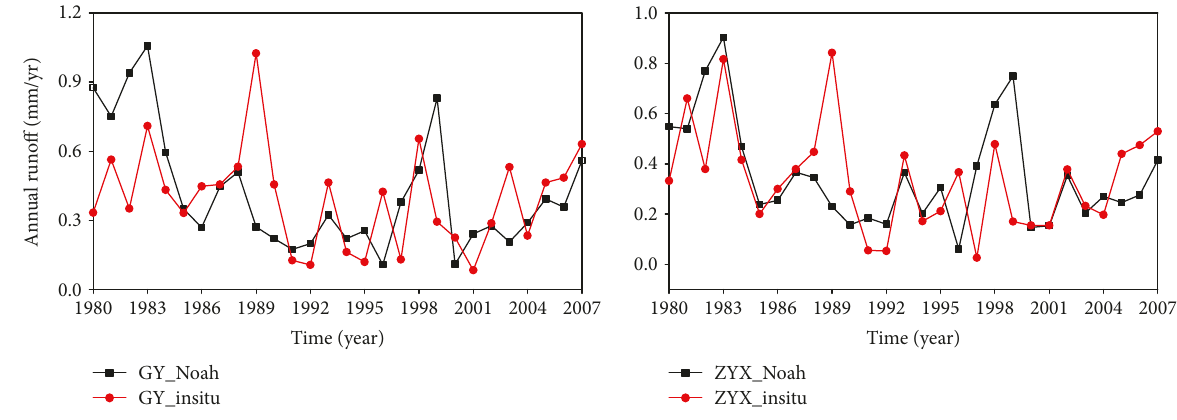
Figure 4: Comparison of measured runo ff and Noah-derived results from 1980 to